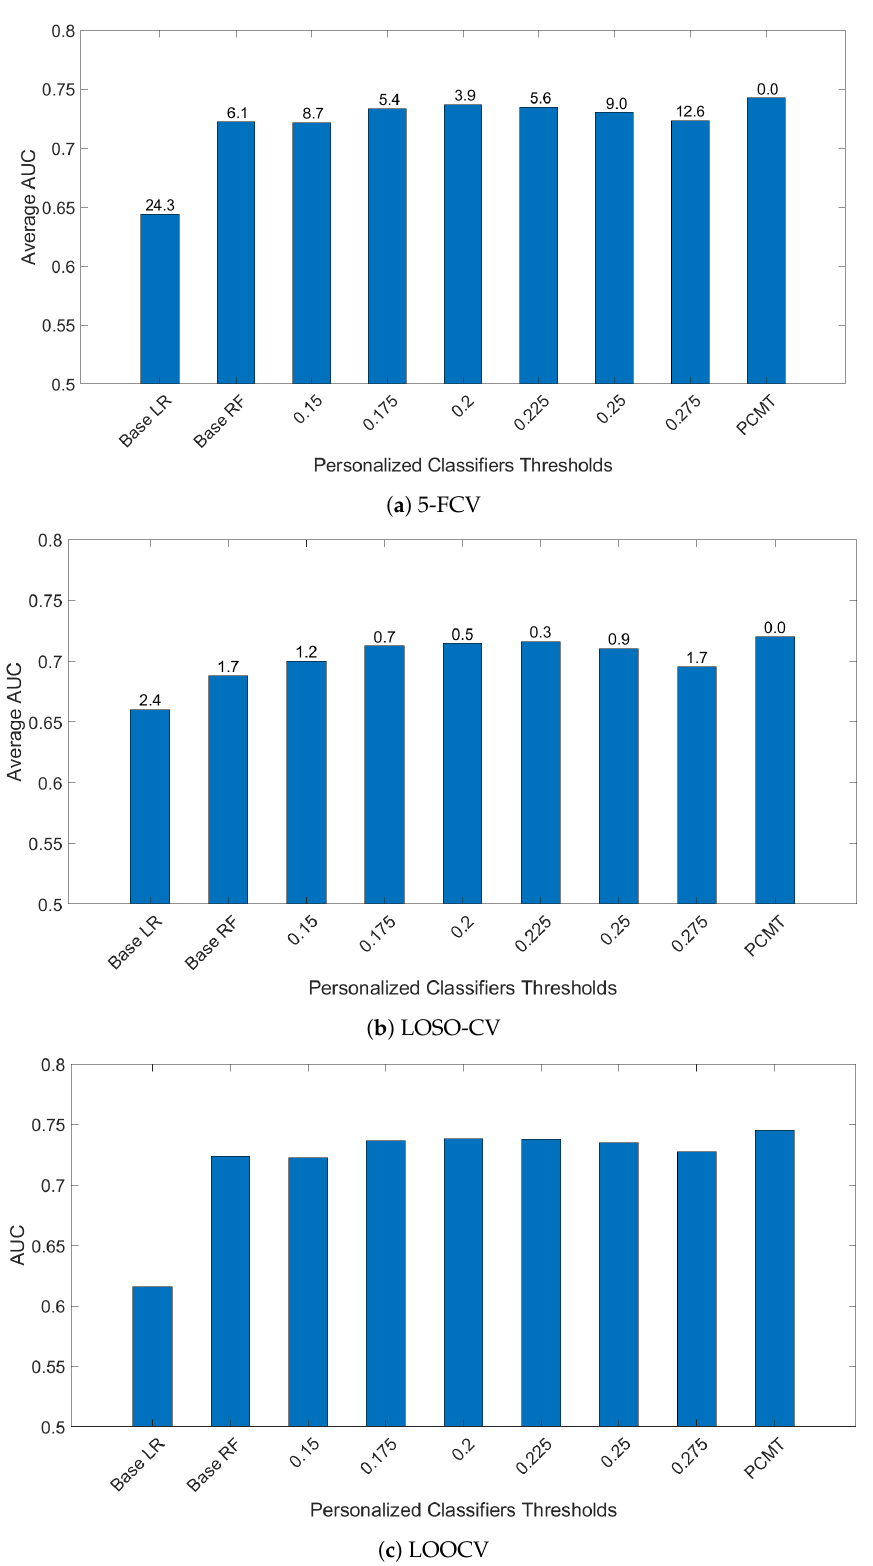
Figure 1. AUC comparison of personalized classifiers for different thresholds in ( a ) 5-FCV, ( b ) LOSO-CV and ( c ) LOOCV. Bar denotes the average AUC. Value on top of the bar denotes the − log 10 ( p _ value ) of the paired t -test between PCMT and that corresponding